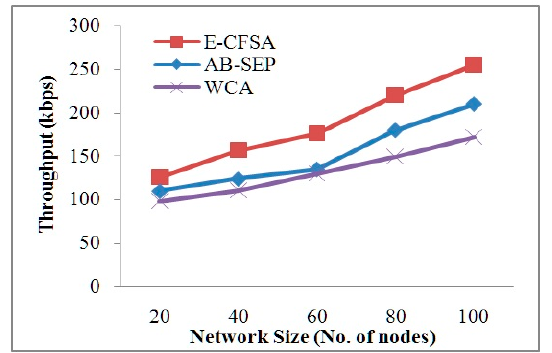
Figure 12. Graph throughput Vs. Network.